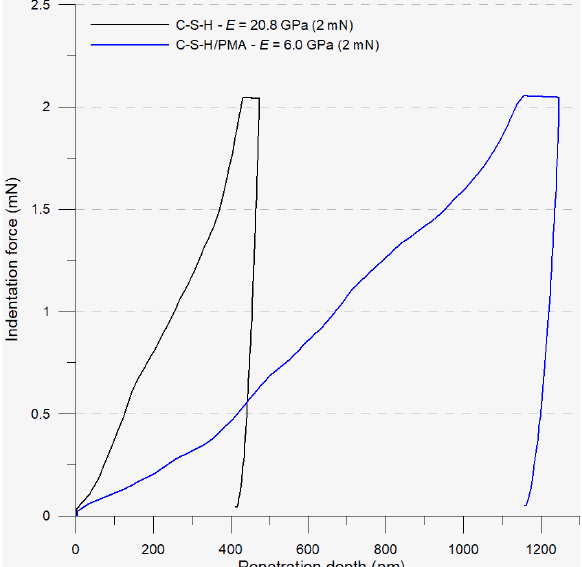
Figure 6. Example of load-penetration curves (2 mN) measured by nanoindentation on samples C-S-H and